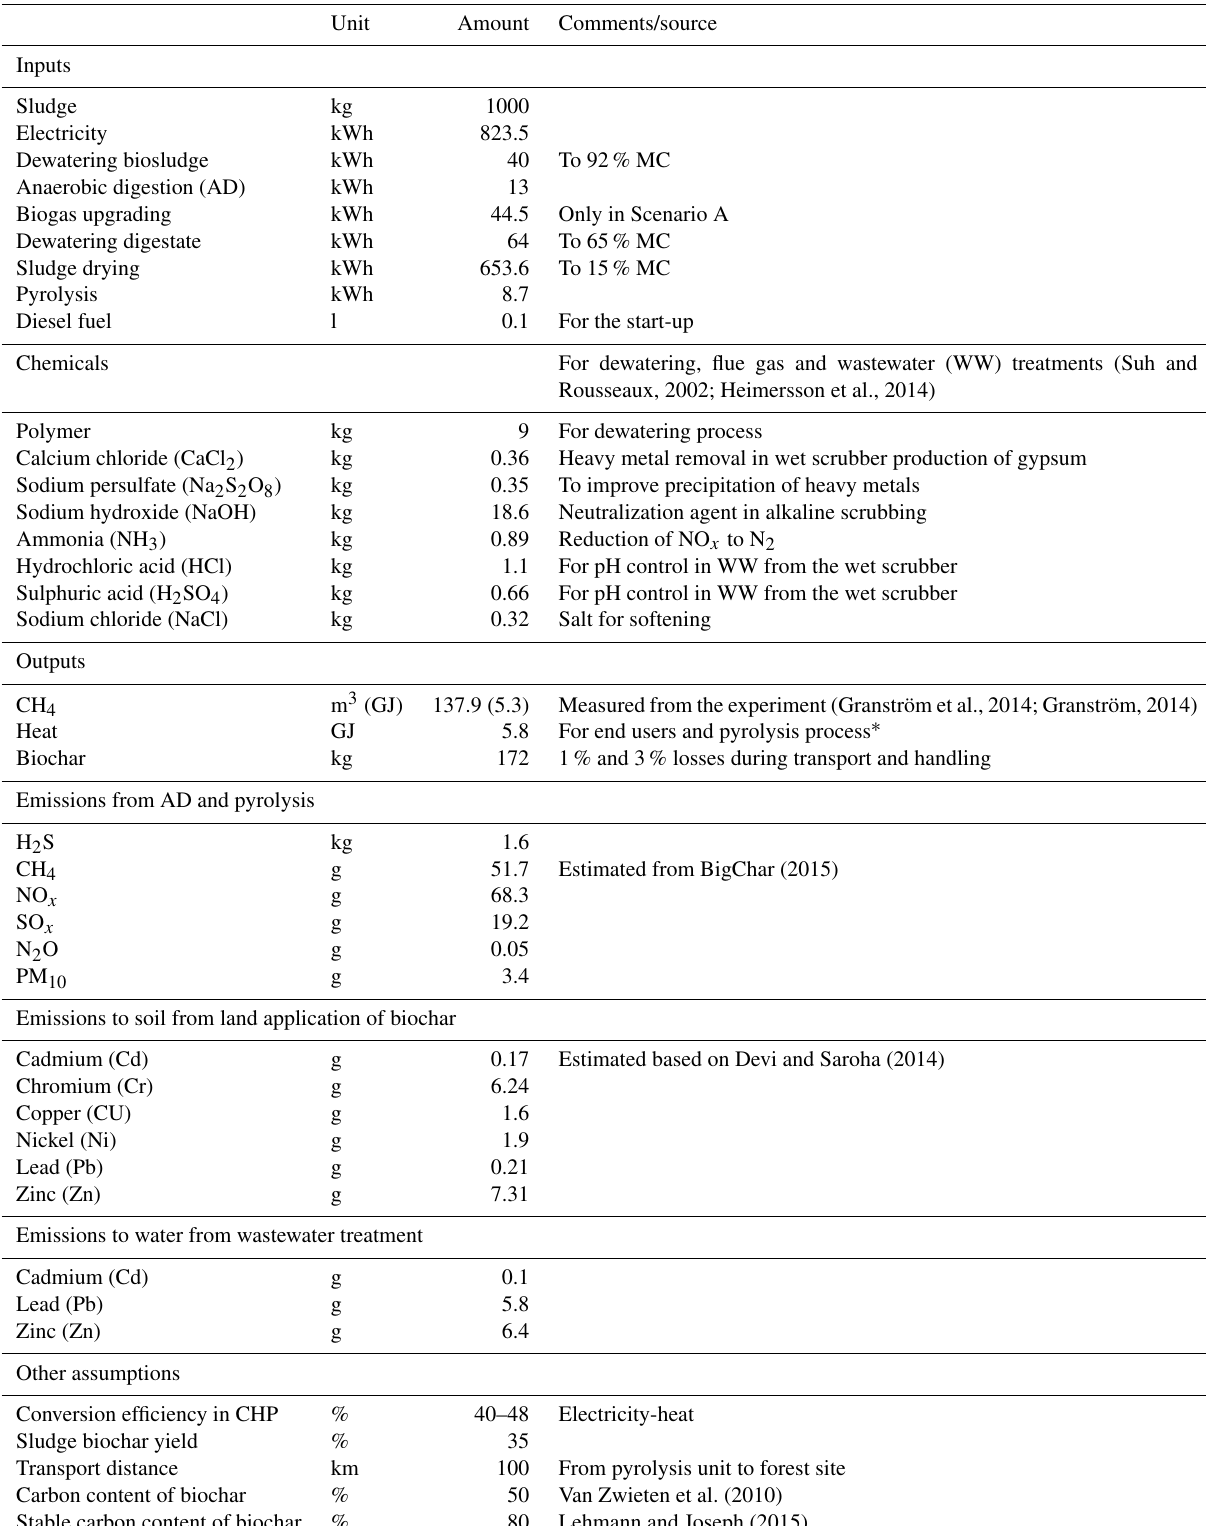
Table 1. Inventory for AD-pyrolysis combination systems (expressed per 1t of dry sludge). Unit Amount